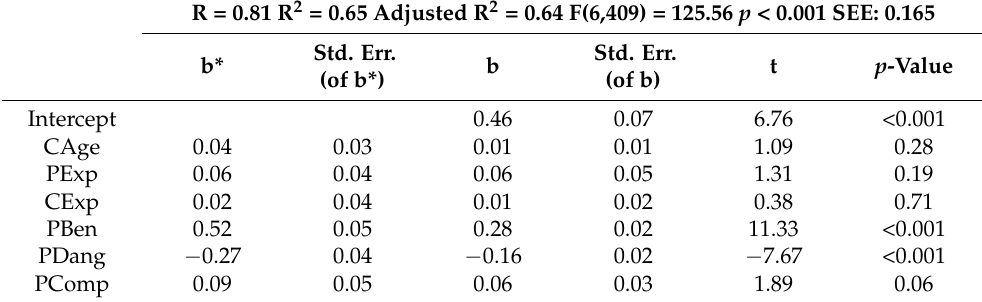
Table 6. Linear regression modelling the effects of the explanatory variables and the PERM